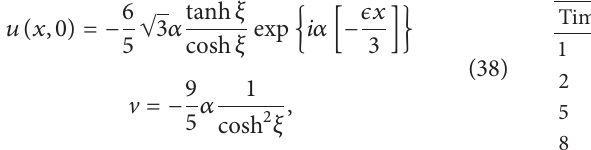
Figure 4: The evolution of the numerical solution of imaginary l part of 𝑢 and 𝜖 = 8.0 . Table 1: Errors using implicit midpoint rule.